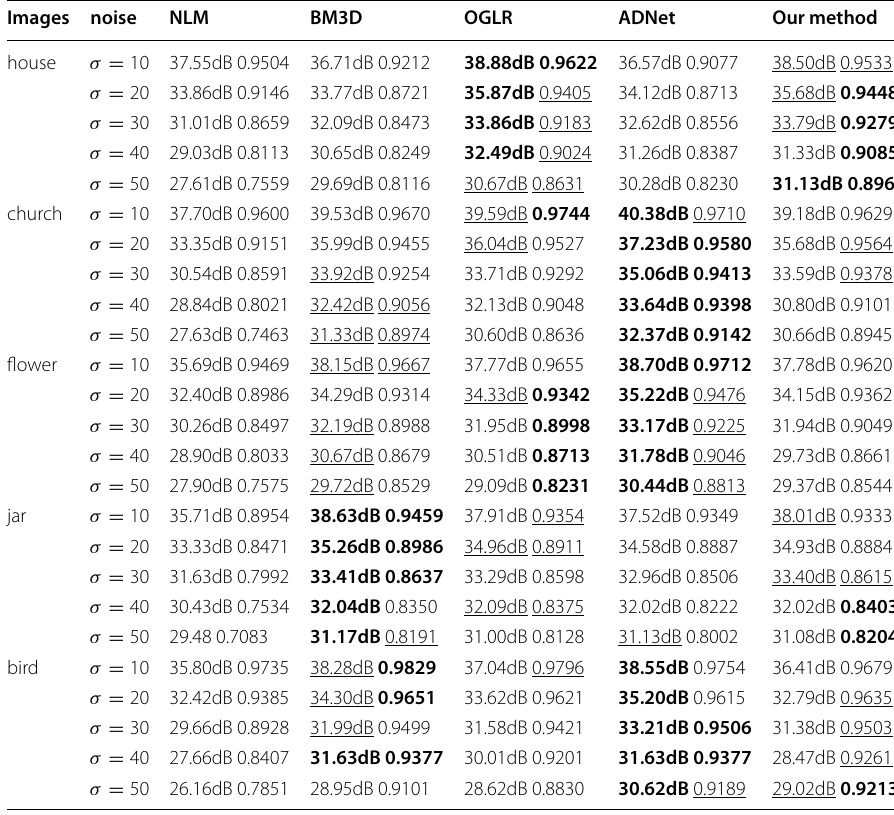
Bold and underline to mark the best and the second best results for each quality index, respectively